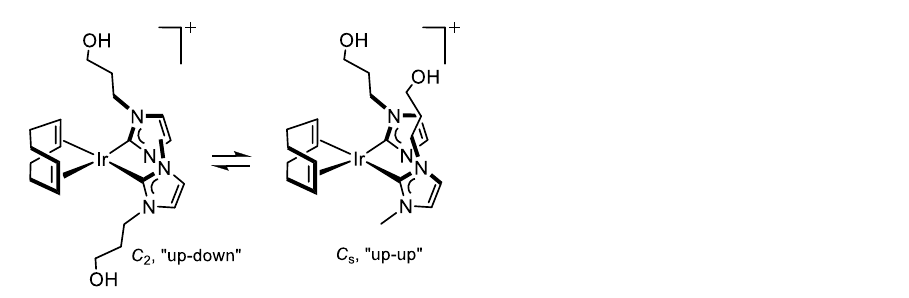
Figure 3. Equilibrium between the two diastereomers of compound [Ir(cod){MeIm(CH 2 ) 3 OH} 2 ]Cl ( 9